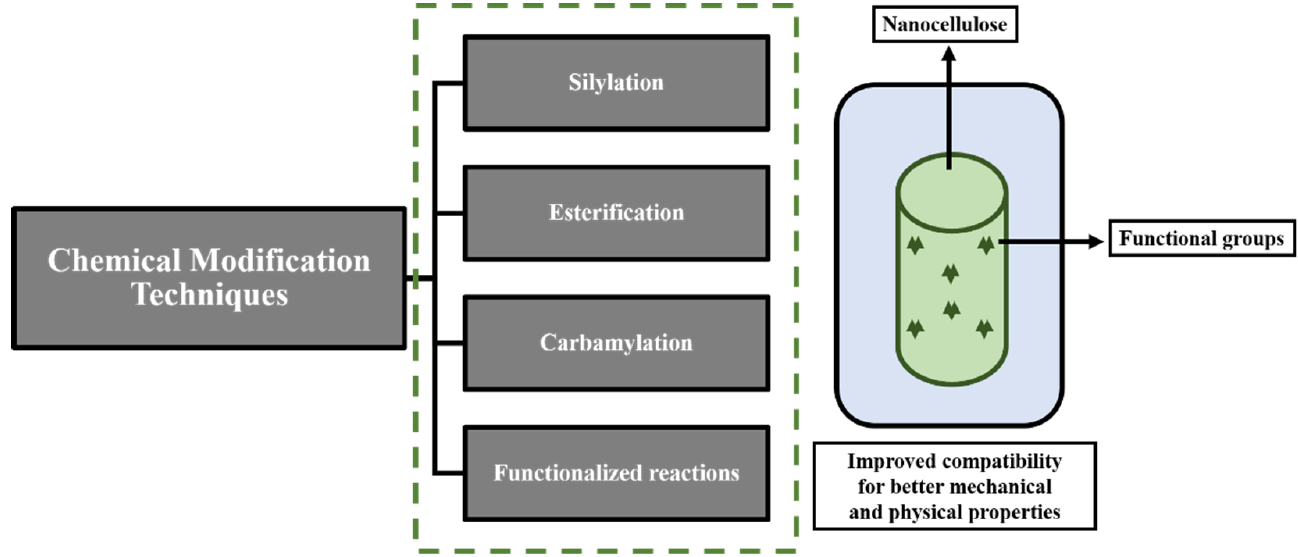
Figure 5. Scheme for various nanocellulose modification methods. Table 3. Nanocellulose treatment methods and characteristics.